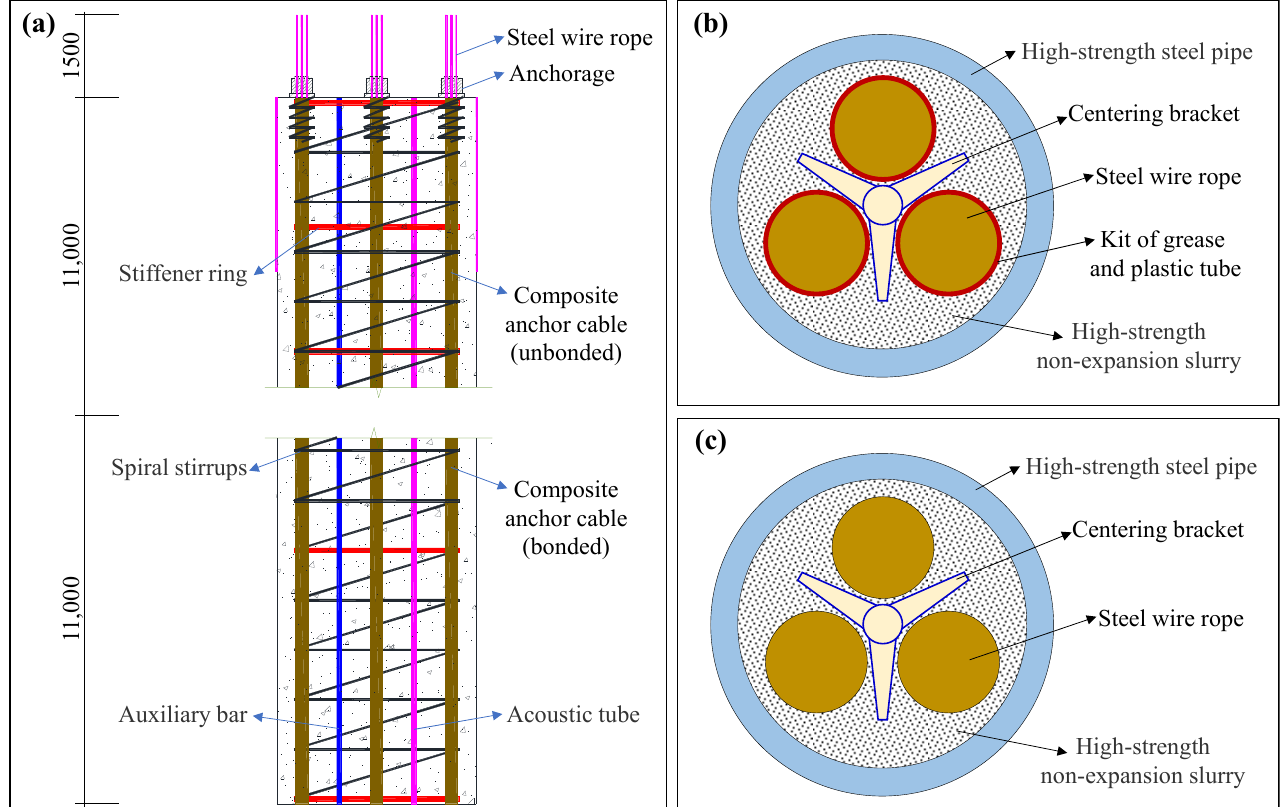
Figure 2. Diagram of the prestressed uplift pile with semi ‐ bonded composite anchor: ( a ) is the pile’s reinforcement diagram; ( b ) and ( c ) are the unbonded and bonded section of the composite anchor cable, respectively.